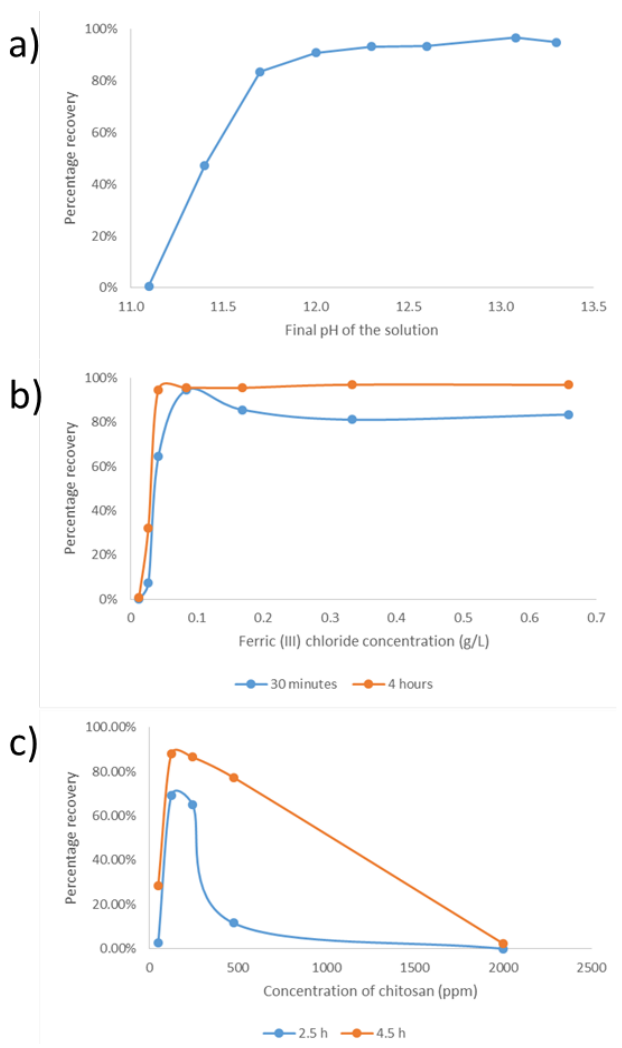
Figure 2. Harvesting efficiency: ( a ) Sodium hydroxide, ( b ) ferric chloride, ( c ) chitosan.